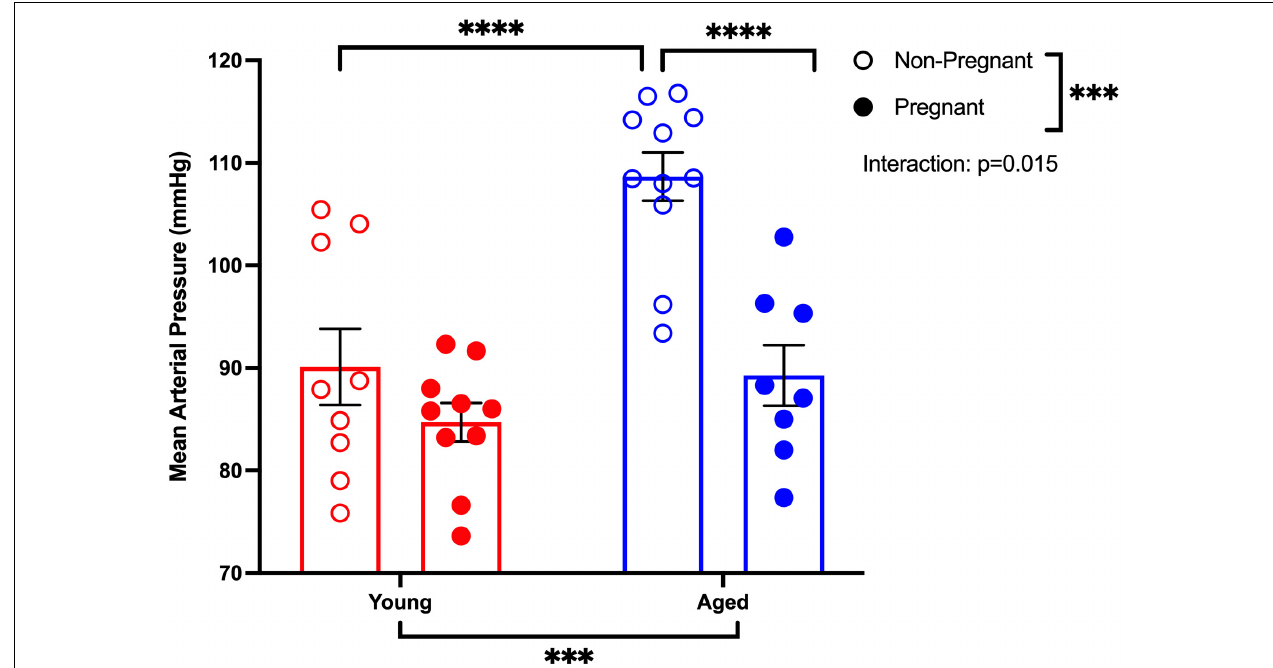
FIGURE 1 | Pregnancy reduced the mean arterial pressure in aged pregnant rats. Mean arterial blood pressure recordings (MAP) of young (3–4 months; in red) and aged (9–9.5 months; in blue) pregnant (on gestational day 20; closed circles) and non-pregnant (age-matched; open circles) rats. Data presented as mean ± SEM; analyzed by two-way ANOVA with Sidak’s multiple comparisons post hoc test; ∗∗∗ p < 0.001, ∗∗∗∗ p < 0.0001; n = 9–10/group.